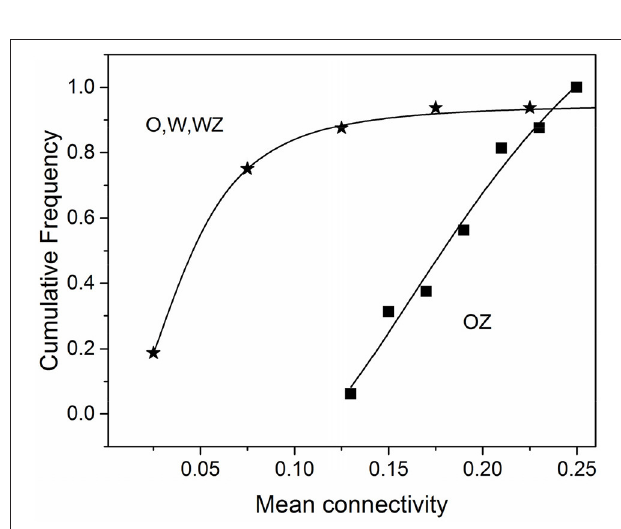
FIGURE 4 | Cumulative frequency distribution of the mean connectivity for the condition of odorant + zinc nanoparticles (OZ) compared to conditions of odorant (O), water vapor + zinc nanoparticles (WZ), and water vapor alone (W). Data were taken from Table 1